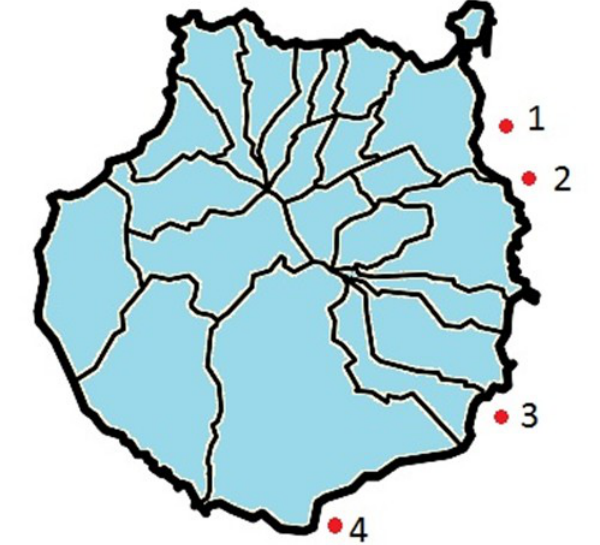
Figure 2. Localisation sampling points on the island of Gran Canaria. 1- Las Palmas de Gran Canaria; 2- Jinámar; 3- Punta Salina; 4- Los